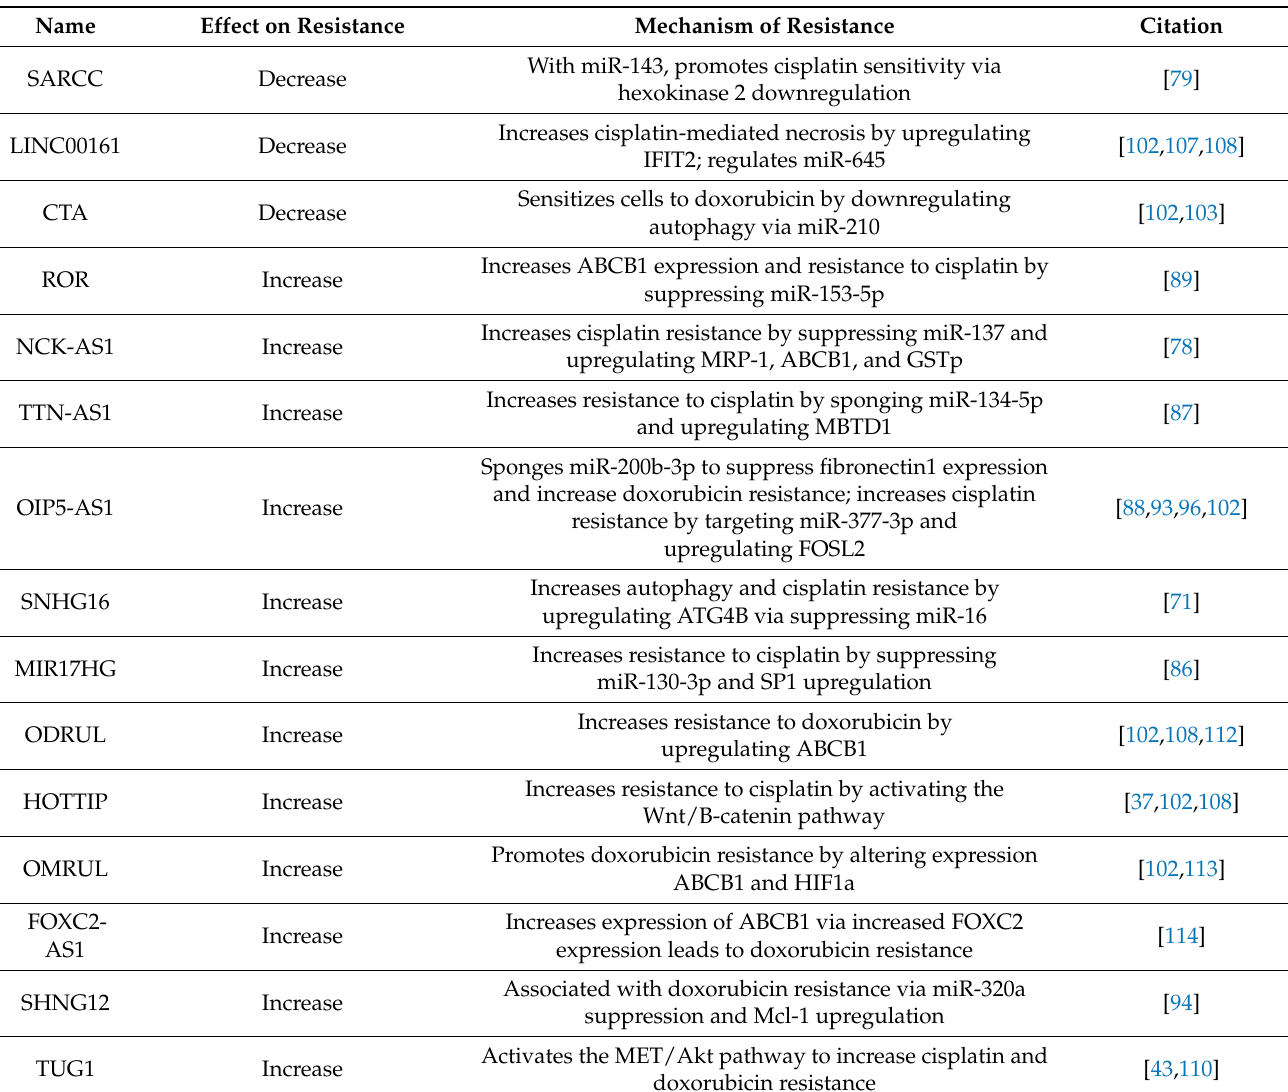
Table 3. LncRNA is implicated in osteosarcoma treatment